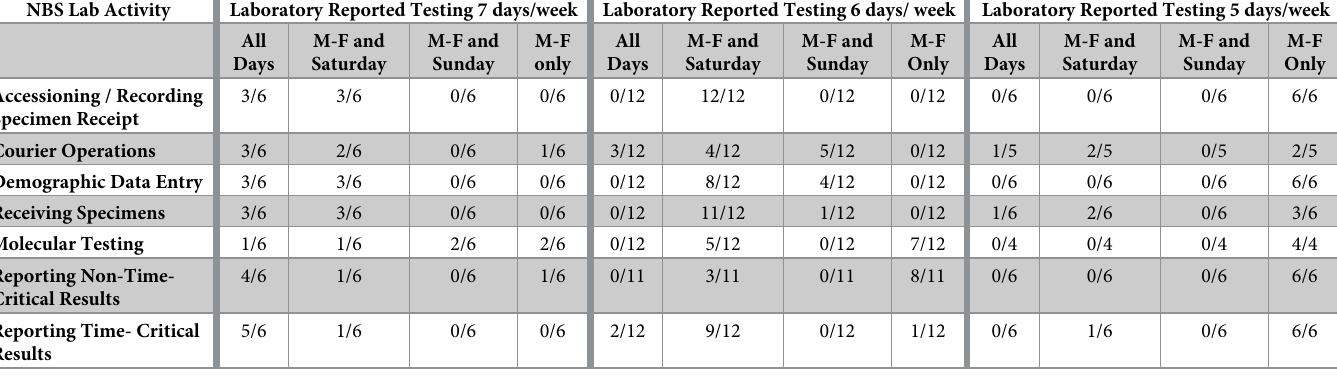
Table 7. Laboratory weekend operations vary across newborn screening programs, categorized by the number of days a laboratory reports testing dried blood slot specimens � . NBS Lab Activity